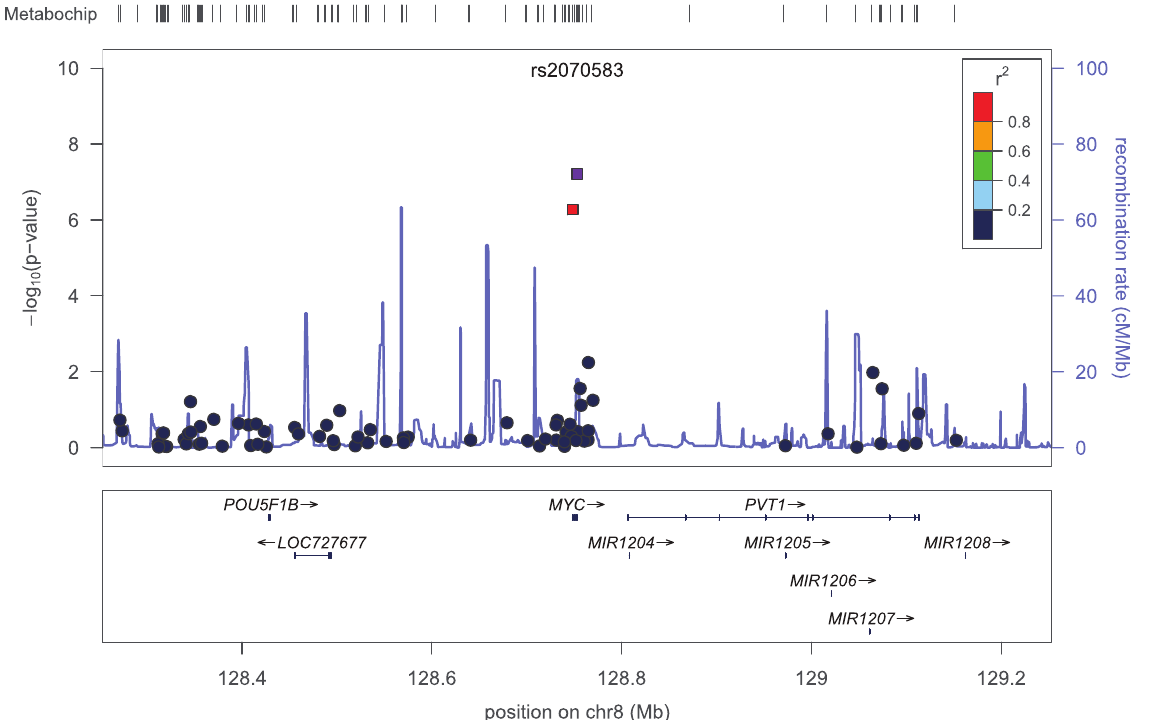
Fig. 2. Regional plots of the MYC loci showing two SNPs and their LD. The X-axis shows chromosomal positions and genes, the left Y-axis shows the – log10P-values and the right Y-axis shows the recombination rate across the region using HapMap CEU linkage disequilibrium. Plotted SNPs are marked by